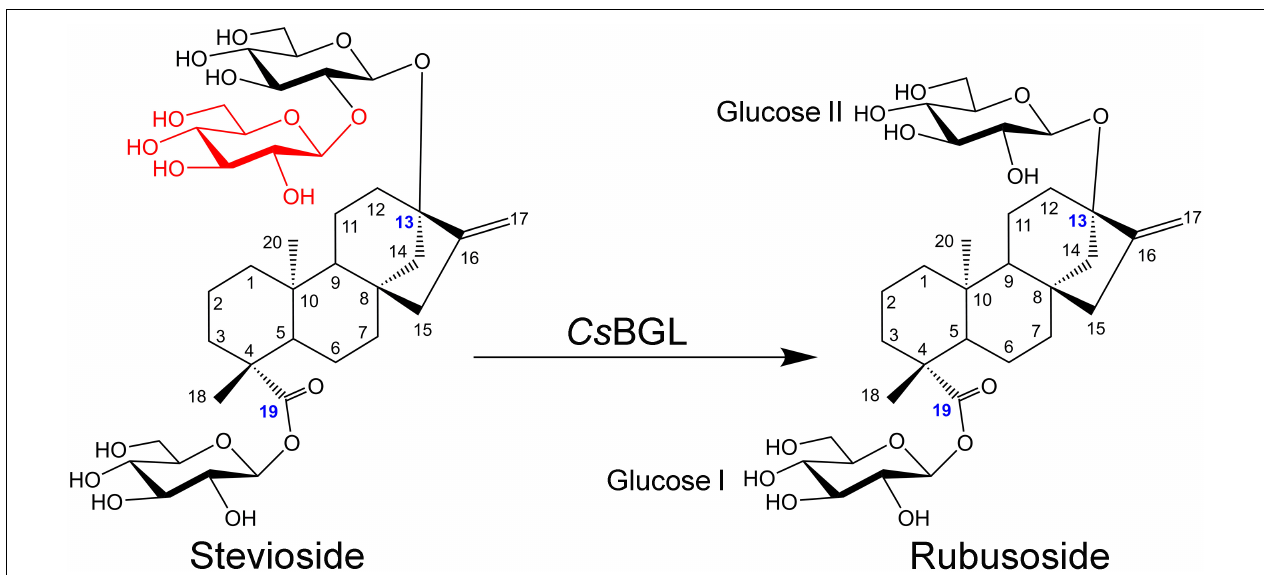
FIGURE 8 | Schematic diagram of production of rubusoside from the hydrolysis of stevioside catalyzed by Cs BGL. The blue numbers label the carbon atoms that link with the sugar groups, the different structural moiety between stevioside and rubusoside is displayed in red.